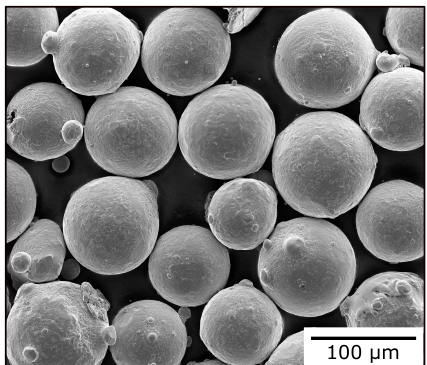
Figure 1. IN718 powder used in SEBM process. Image taken by Helios NanoLab DualBeam 600 FIB/SEM (FEI Company, Hillsboro, OR, USA).